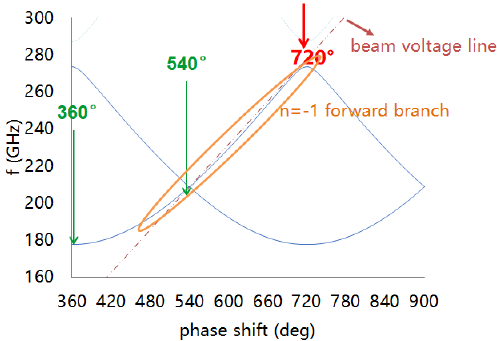
Figure 6. Dispersion curves of the folded waveguide circuit. 0.26650.2670.26750.2680.26850.2690.26950.27 Figure 7. Normalized phase velocity of the folded waveguide circuit.